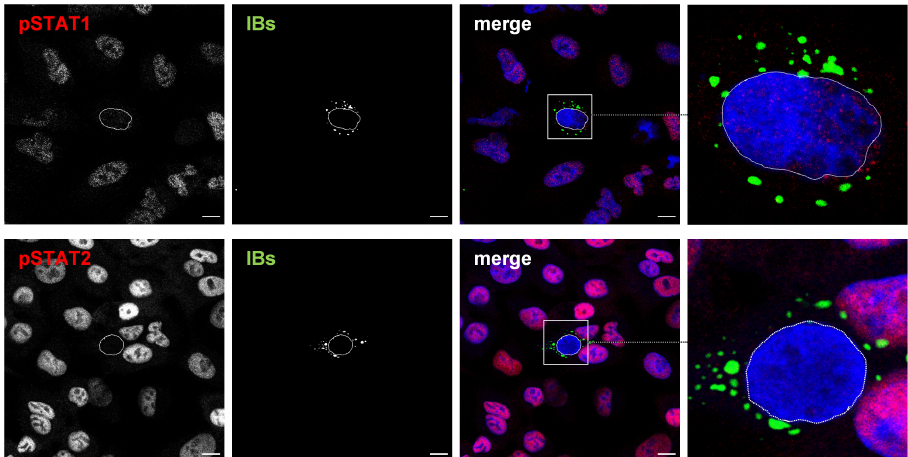
Figure 4. NiV IBs prevent formation of pSTAT in IFN-treated cells. A549 cells were transfected with plasmids encoding NiV N and NiV PeGFP. Then, 22 h after transfection, cells were treated with IFN- β (1000 U/mL) for 40 min. Afterwards, cells were fixed with PFA, permeabilized with methanol at − 20 ◦ C, and endogenous pSTAT1 and pSTAT2 were stained with specific antibodies (red). IBs were detected by eGFP autofluorescence (green). Nuclei were counterstained with DAPI (blue). The greyscale image of the labeled proteins as well as the colorized merged images are shown. The dashed lines highlight the nuclei of IB-containing cells. Boxed areas are displayed in a higher magnification. Scale bars, 10 µ m.